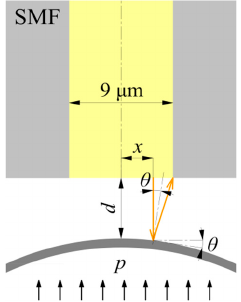
Figure 6. Schematic of the Fabry-Perot cavity between the end surface of fiber and membrane.